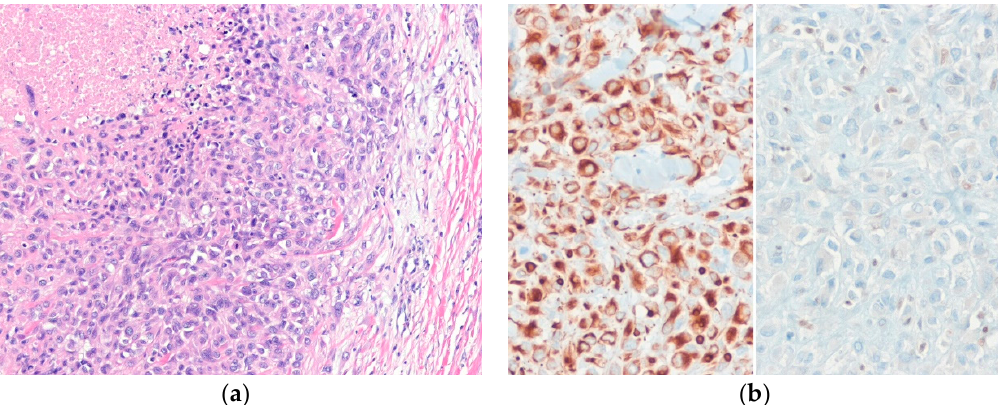
Figure 9. Classic-type epithelioid sarcoma. ( a ) The tumor shows sheets of epithelioid cells with eosinophilic cytoplasm and vesicular nuclei and central necrosis; ( b ) The tumor cells are positive for cytokeratin (AE1/AE3) (left) and show loss of SMARCB1 (INI1) expression (right) (H&E stain, original magnification 100× ( a ); cytokeratin (AE1/AE3) and SMARCB1 (INI1) immunostain, original magnification 200× ( b )).